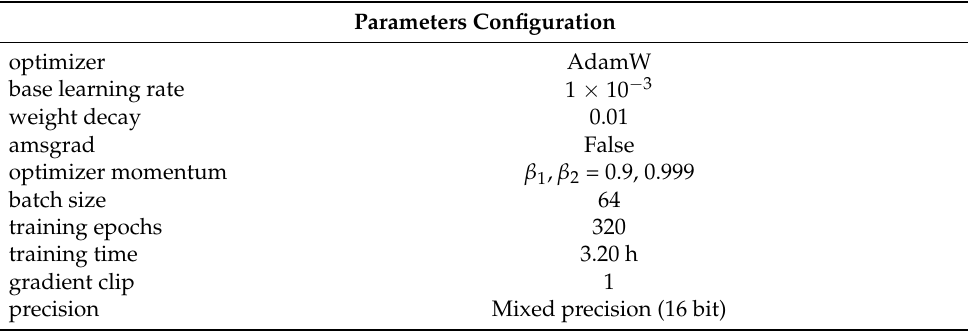
Table 1. Values of parameters used for network